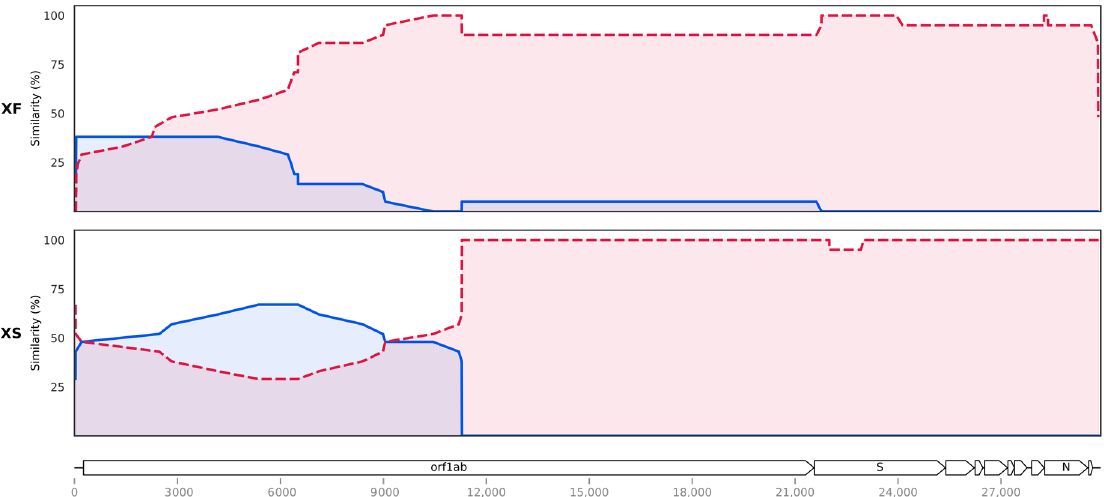
Figure 2. Comparison of the recombination patterns of the AYBA-RS Deltacron and the Deltacrons XD, XF, and XS. Similarity values between the recombinant and the Delta and Omicron parental sequences within a window length of 20 nucleotides along the genome. The legend describes the reference of each comparison. The recombination breakpoints, i.e., points where the lines cross over each other, are distinct for each of the recombinants, and this supports our conclusion of their independent evolution. Recombination plots generated with HybridCheck [29]. Sequences analysed in this plot: Brazil/RS-FIOCRUZ-8390/2022 (AYBA-RS), Brazil/SC-FIOCRUZ-43556-R2/2021 (Delta) and USA/CA-OC-FG-228571/2021 (Omicron) as its parental sequences; France/HDF-IPP54794/2022 (XD), Sweden/37524448XXP/2021 (Delta) and Finland/P-1301/2022 (Omicron) as its parental sequences; England/PHEC-YYN8J41/2022 (XF), South Africa/NHLS-UCT-GS-AF27/2021 (Delta) and South Africa/NICD-N28358/2022 (Omicron) as its parental sequences; USA/CO-CDC-FG-248528/2022 (XS), Latvia/3410639/2021 (Delta) and USA/CA-CDC-FG-223742/2021 (Omicron) as its parental sequences. Similarity at the y-axis refers to percentage sequence similarity at polymorphic sites only. The SARS-CoV-2 genome map and their respective coordinates are shown at the bottom.